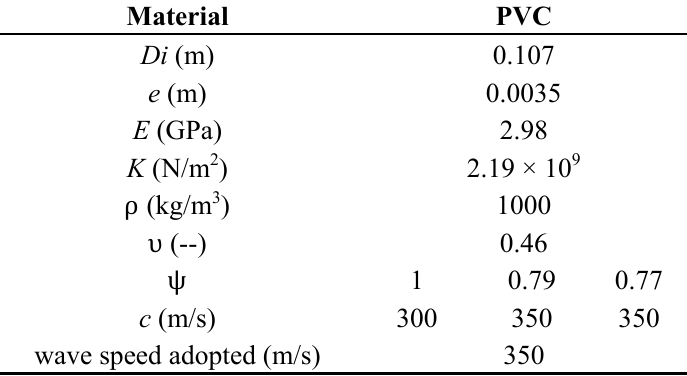
Table 3. Pipe characteristics and wave speed values for each anchoring